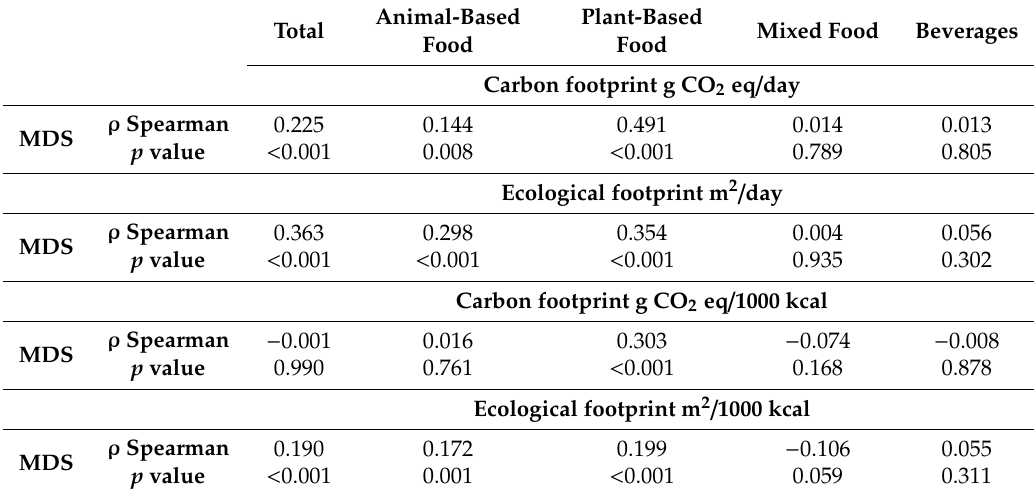
Table 4. Spearman’s correlation coe ffi cients between MDS and carbon and ecological footprints due to total, animal-based, plant-based and other mixed food per day and per 1000 kcal. Animal-Based Total Food